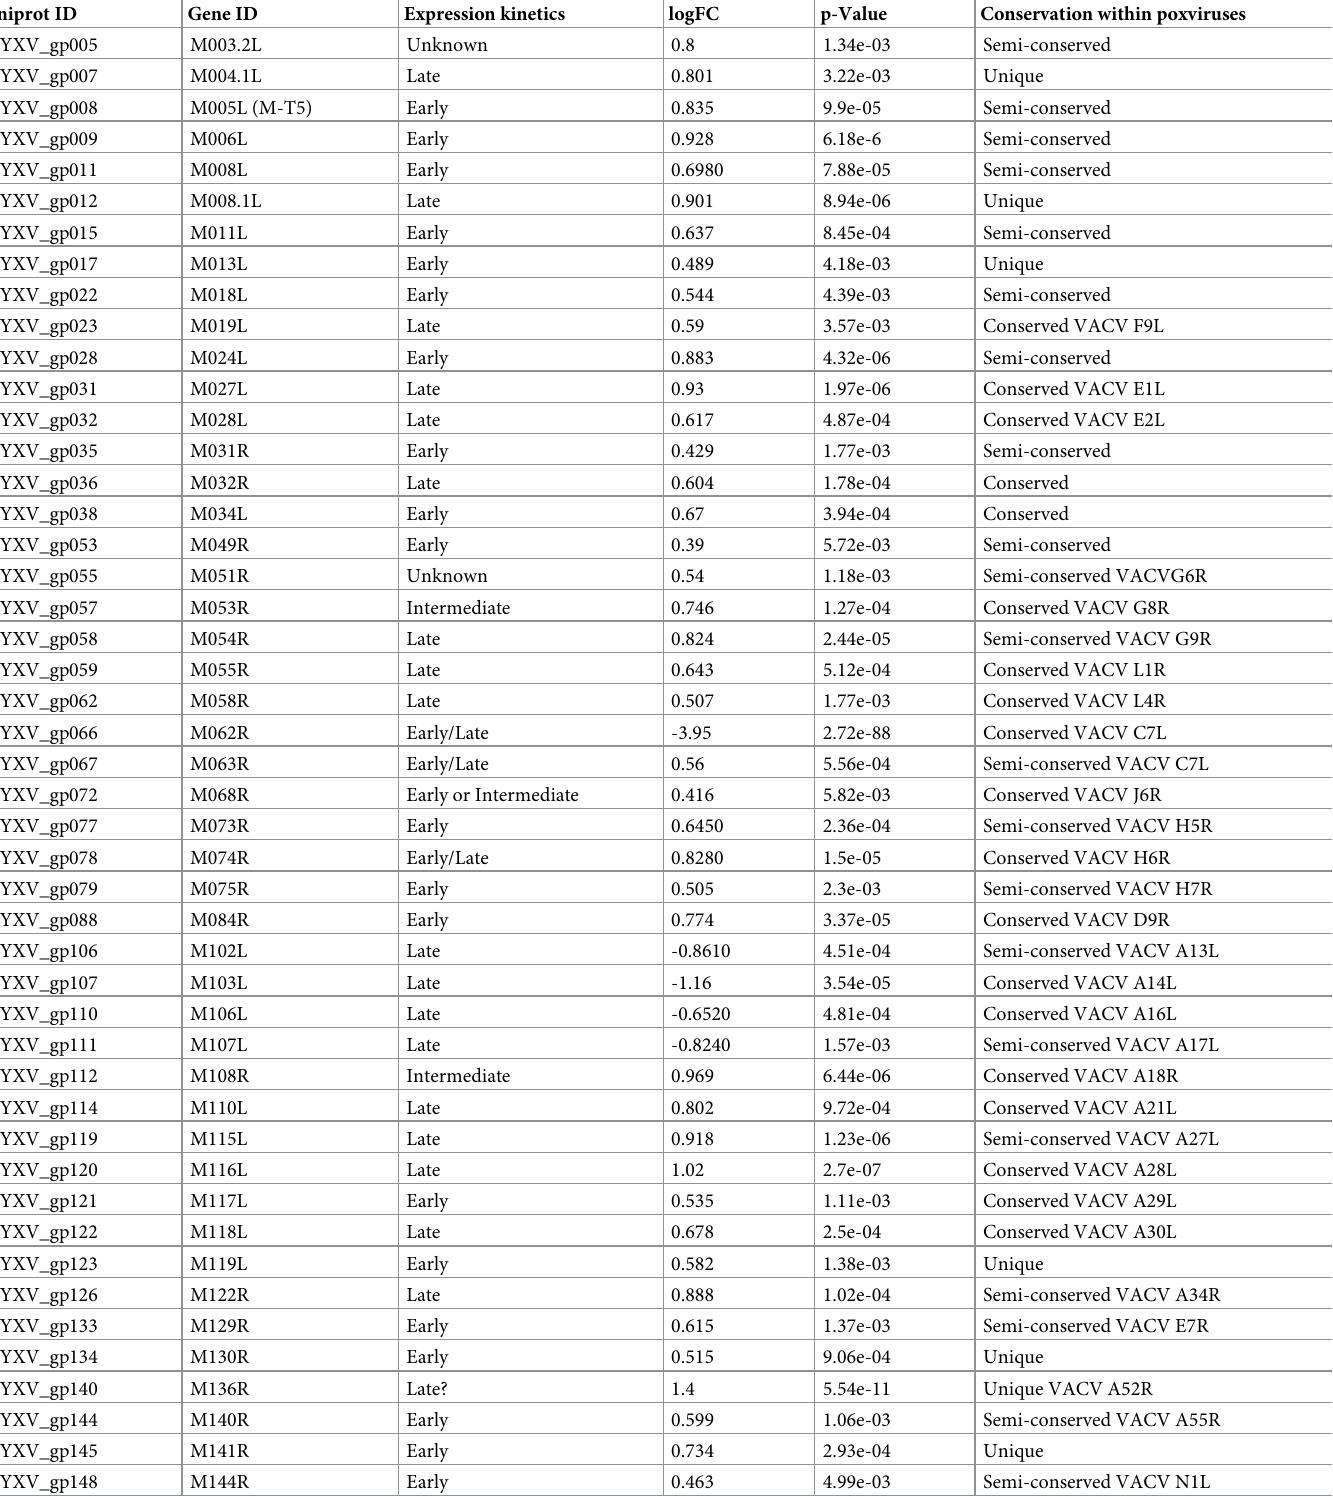
Table 1. Differentially expressed viral gene in Δ M062R and wildtype MYXV in human macrophages. Uniprot